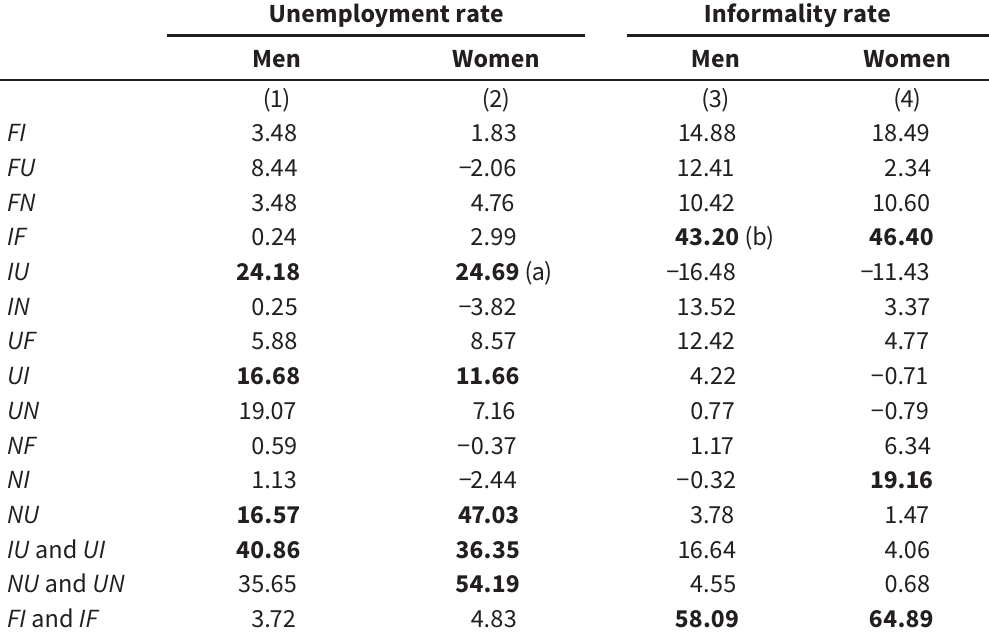
Variance decomposition by gender based on b Unemployment rate Informality rate